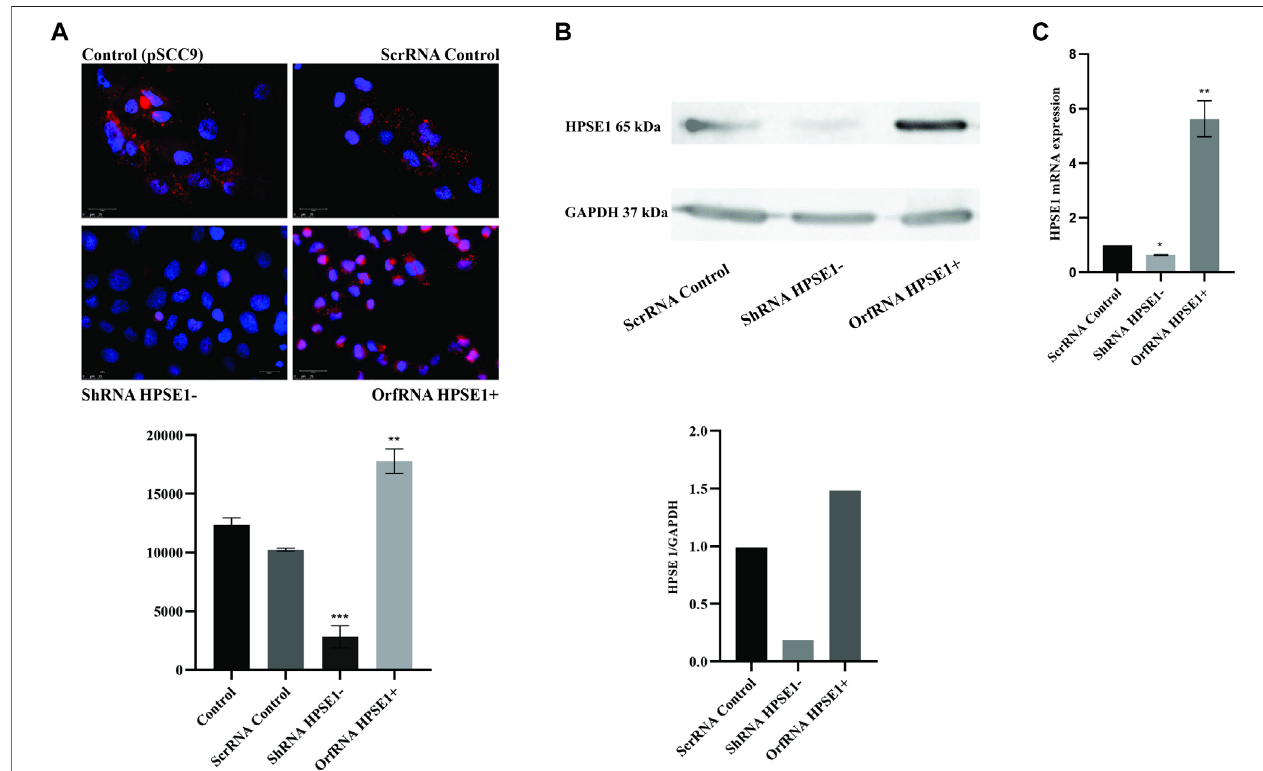
FIGURE 3 | HPSE1knockdownandupregulationef fi ciencyinOSCCcells.Theef fi ciencyofendogenousHPSE1modulationwasveri fi edbyImmuno fl uorescence (A) , Western Blot (B) and RT-qPCR (C) analyzes. For the loss-of-function strategy, SCC-9 cells were transduced with shRNA expressing a vector sequence against HPSE1 (shRNAHPSE1 − )andemptyvector(scrRNAcontrol).Forthegain-of-functionstrategy,SCC-9cellsweretransducedwithaORFcloneinashuttlevectortoenhanceHPSE1 expression (orfRNA HPSE1+), along with mock-transduced cells as described in Methods . shRNA HPSE1 − cells showed a signi fi cant reduction and orfRNA HPSE+ cellsshowedasigni fi cantupregulationofHPSE1inbothmRNAandproteinlevelscomparedtoscrRNAcontrolandparentalmock-transducedSCC-9controlcells(pSCC9), without targeting sequences. Results were statistically determined by ANOVA, followed by Tukey ’ s test, where * p < 0.05, ** p < 0.01, *** p < 0.001, and **** p < 0.0001.